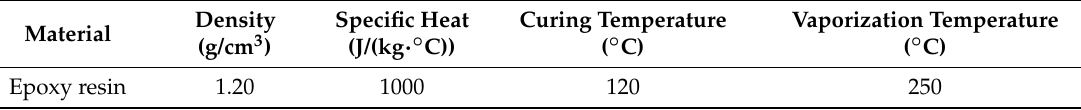
Table 2. Material properties of epoxy resin.